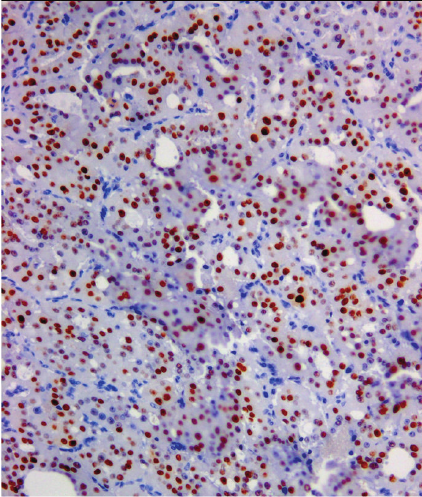
Figure 1: Immunohistochemical features. It should be noted that also Hashimoto thyroiditis may show reactivity for Galectin-3, but it is typical focal and restricted to epithelial cells in the areas of lymphocytic infiltrations. Gal-3 in OC: note the diffuse reaction in tumor cells (arrowheads).